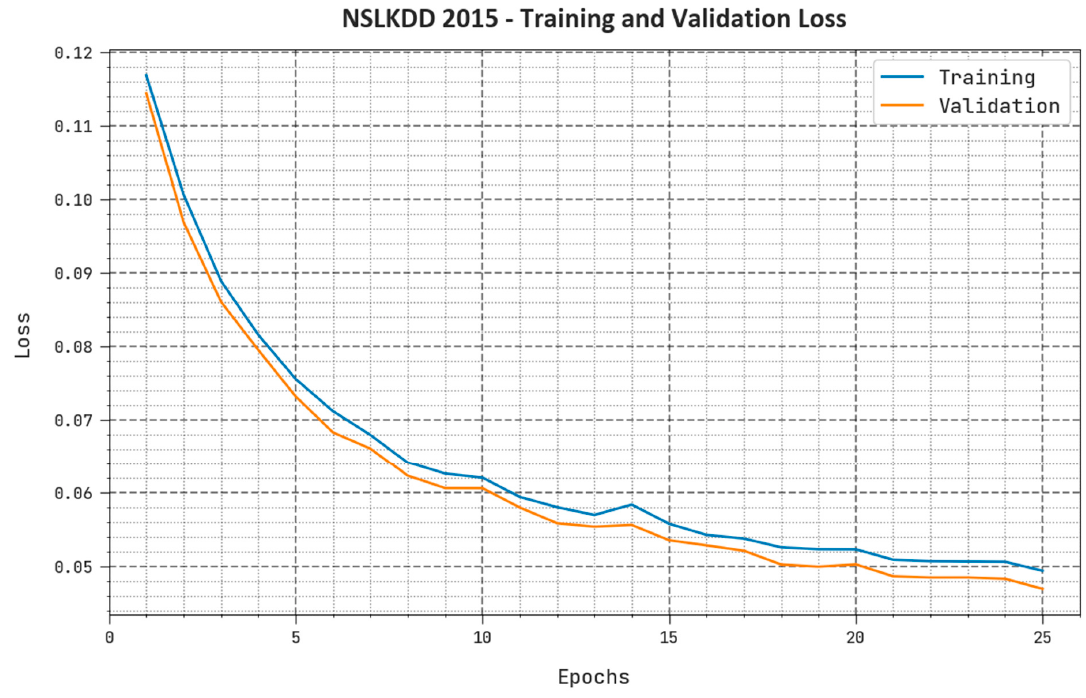
Figure 5. TLOS and VLOS outcome of XAIID-SCPS system on NSLKDD2015 dataset.